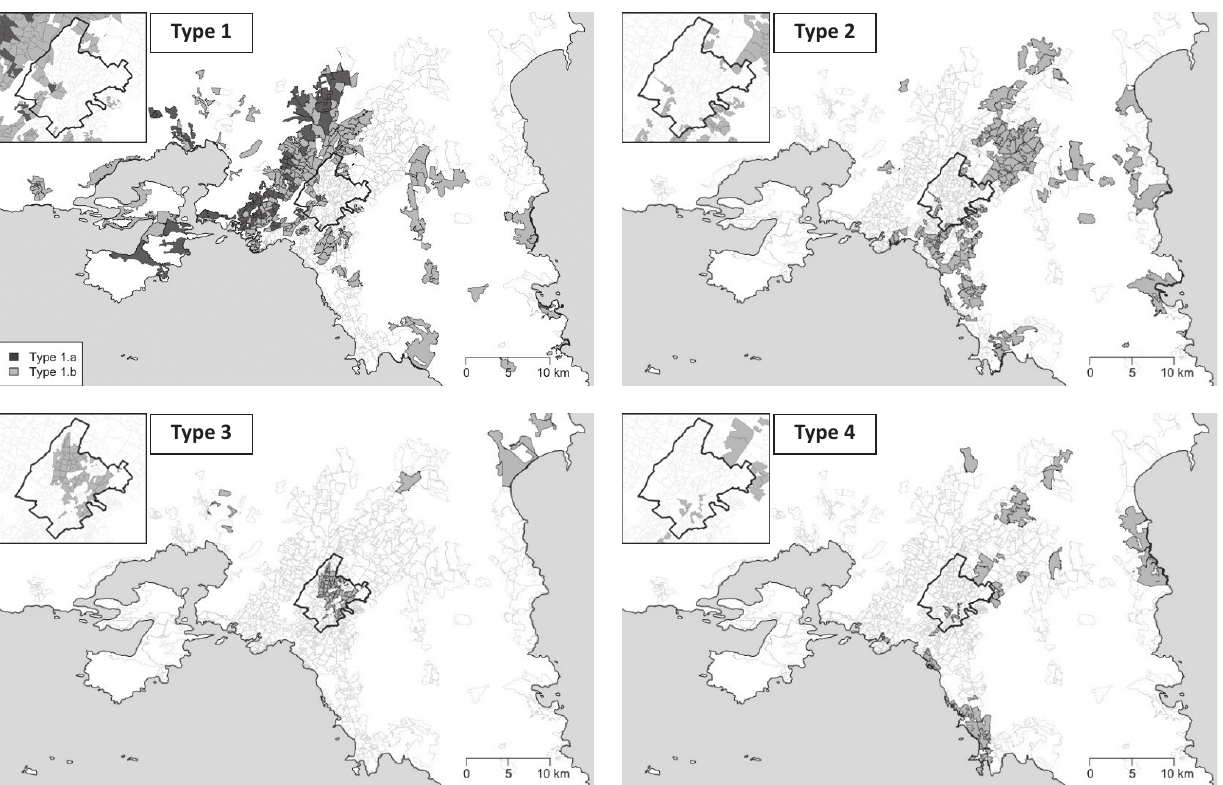
Figure 3. Location patterns of residential areas according to changing social profile trends in Athens metropolitan area (1991–2011). Notes: Spatial units represented on theses maps correspond to aggregates of URANUs of the metropolitan area of Athens. Percentages in brackets represent the share of individuals aged 25–54 living in this type of area in